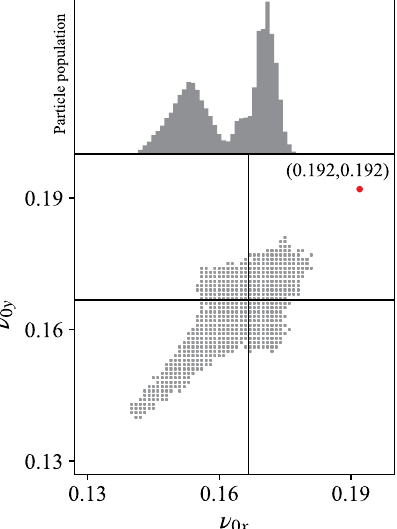
FIG. 12. Incoherent tune spread of the waterbag beam exhibited in Fig. 11, after the initial particle distribution collapsed due to the coherent core resonance. The vertical and horizontal solid lines in the lower panel represent ν 0 x ð 0 y Þ ¼ 1 = 6